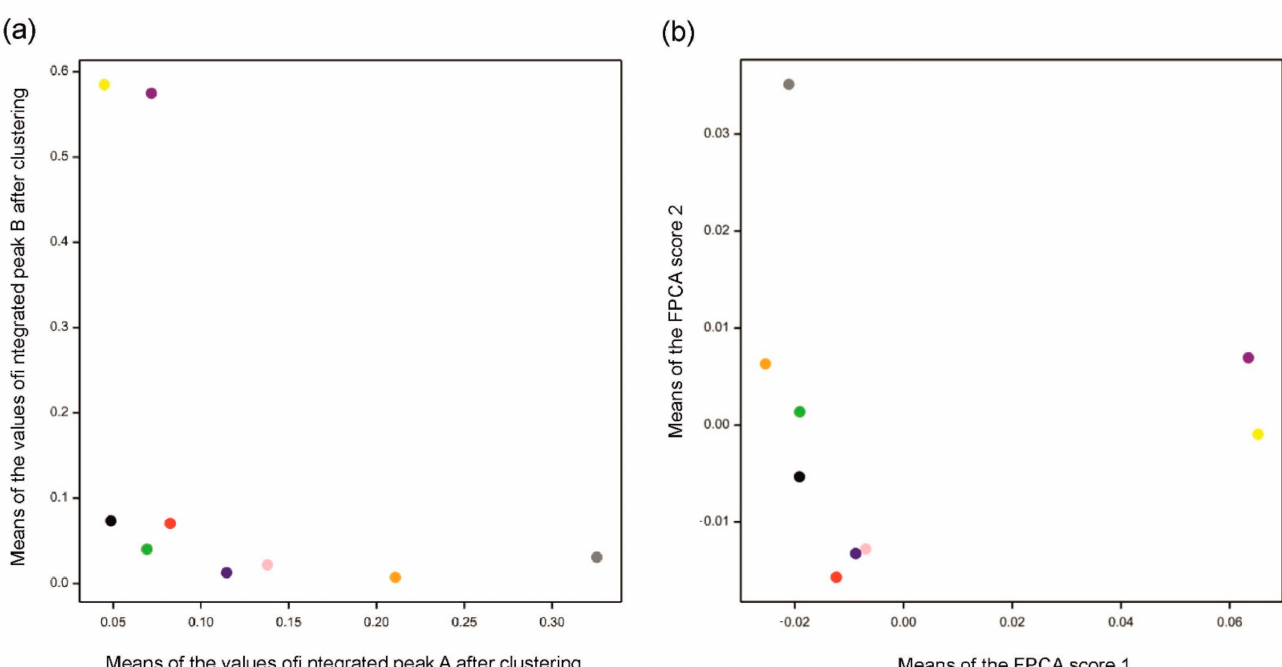
Figure 6. Means for varieties obtained by ( a ) Method 1 using clustering and ( b ) Method 2 using functional principal component analysis (FPCA). Mean values in ( a ) were computed over four replications for each variety over integrated peaks A and B obtained by clustering. Mean values in ( b ) were computed over four replications for each variety for the two first FPC scores. Different colors indicate varieties (see caption of Figure 4). Note that positions of varieties along FPC score 1 correspond to those along the values of peak B and positions along FPC score 2 correspond to those for peak